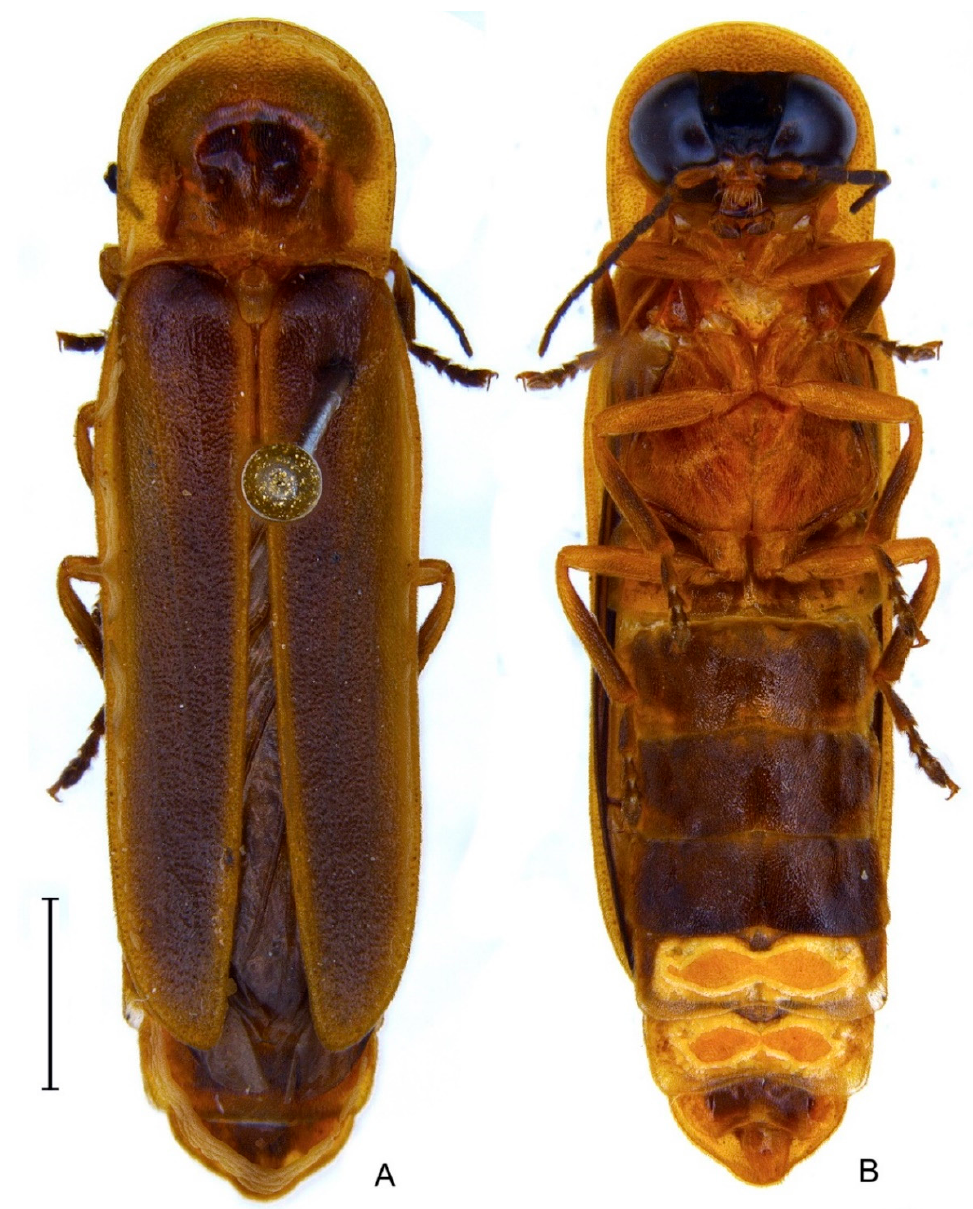
Figure 3. Zoiudo rosae sp. nov., habitus ( A ) dorsal, ( B ) ventral. Scale bar: 3 mm.